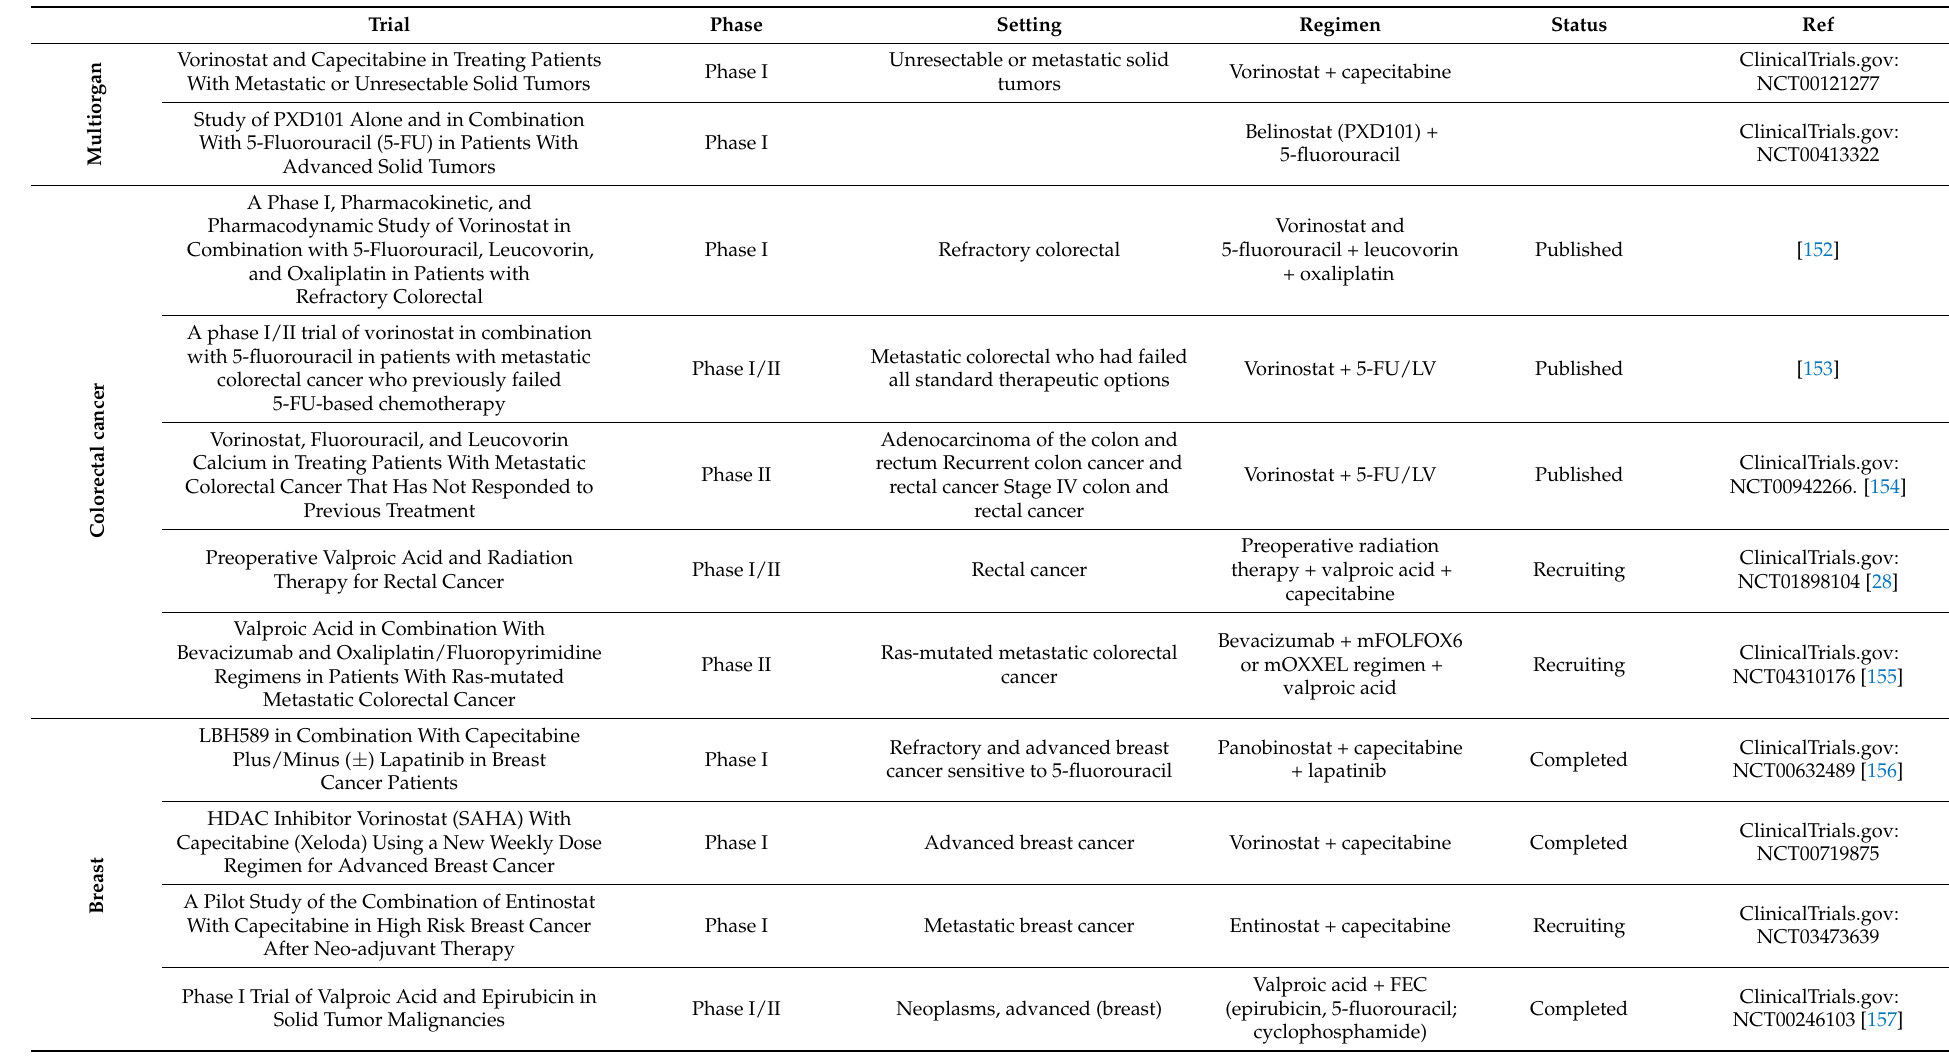
Table 1. Overview of clinical trials evaluating the combination of HDAC inhibitors with fluoropyrimidines in solid